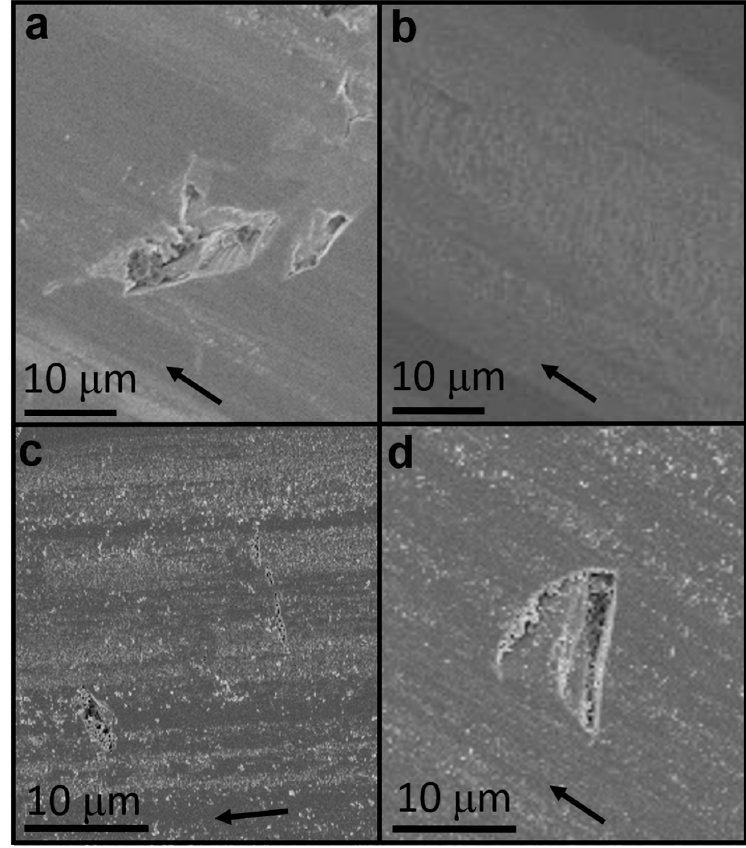
Figure 5. SEM image of worn surface. ( a ) Pure HPMC and ( b ) IF-MoS 2 -; ( c ) 2H-MoS 2 -; and ( d ) MoO 3 - Figure 5. SEMimageofwornsurface. ( a )PureHPMCand( b )IF-MoS 2 -; ( c )2H-MoS 2 -; and( d )MoO 3 -added added HPMC. The arrows show the sliding direction. HPMC. The arrows show the sliding